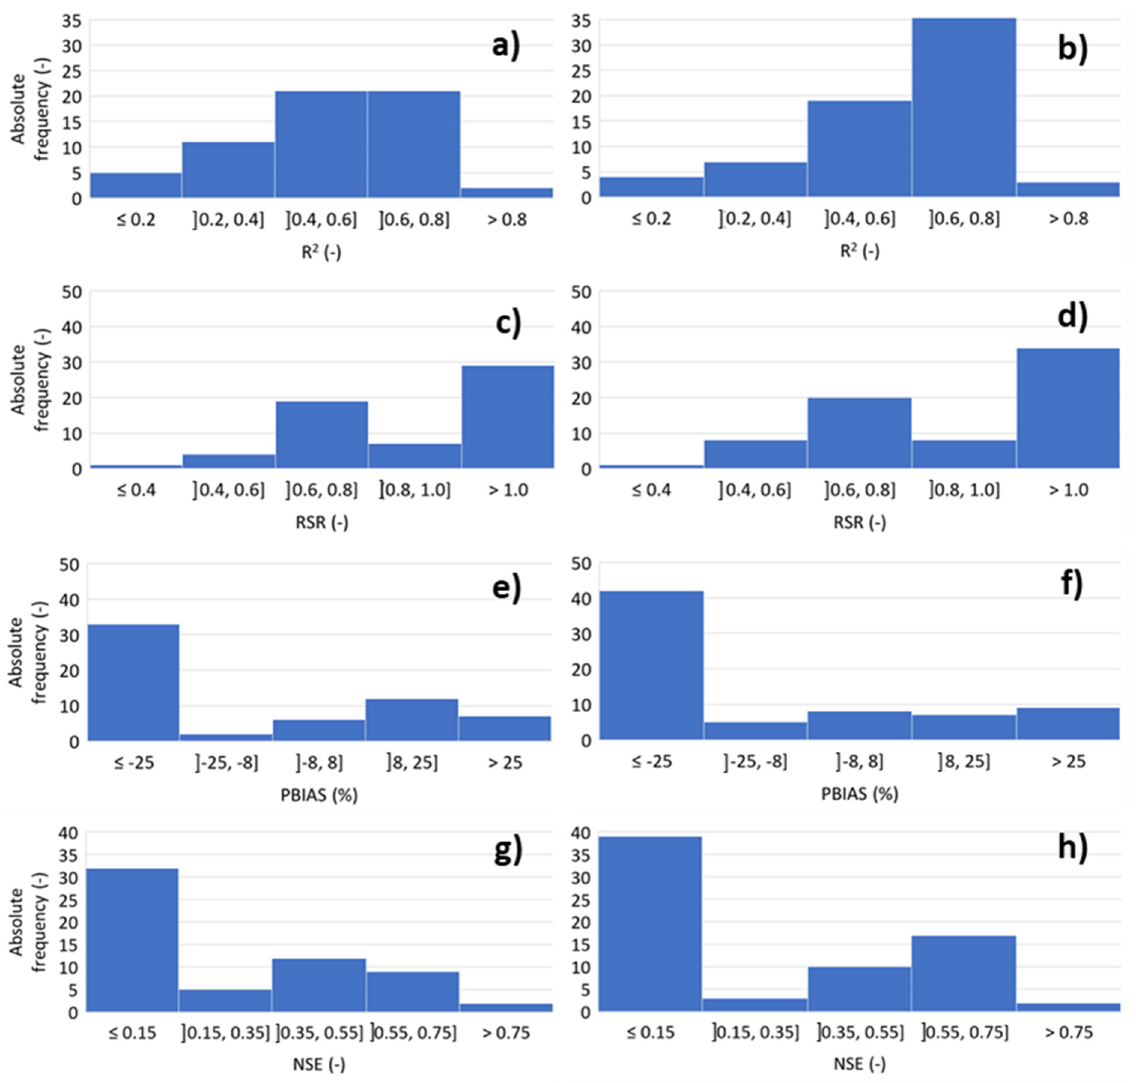
Figure 3. Histograms with the statistical parameters obtained at 73 hydrometric stations during model evaluation: ( a , b ) coefficient of determination (R 2 ) for calibration and validation periods, respectively; ( c , d ) root mean square error-observation standard deviation ratio (RSR) for calibration and validation periods, respectively; ( e , f ) percent bias (PBIAS) for calibration and validation periods, respectively; ( g , h ) model efficiency (NSE) for calibration and validation periods,